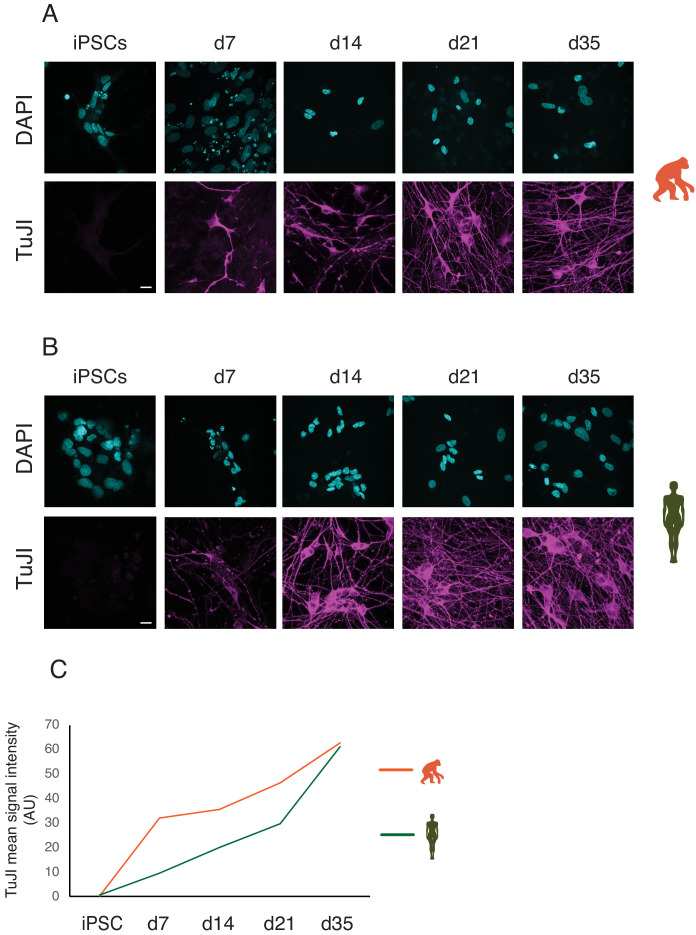
iNs express neuronal markers.Time course of TUJI expression during differentiation of iNs from iPSCs in chimpanzee (A, SandraA) and human (B, 409B2). Magenta: TUJI; cyan: DAPI. Scale bars are 20 µm. (C) Quantification of TUJI signal intensity in chimpanzee (orange) and human (green) iNs. The intensity of the signal was quantified using FiJI and is expressed as AU (arbitrary unit; see Materials and methods).